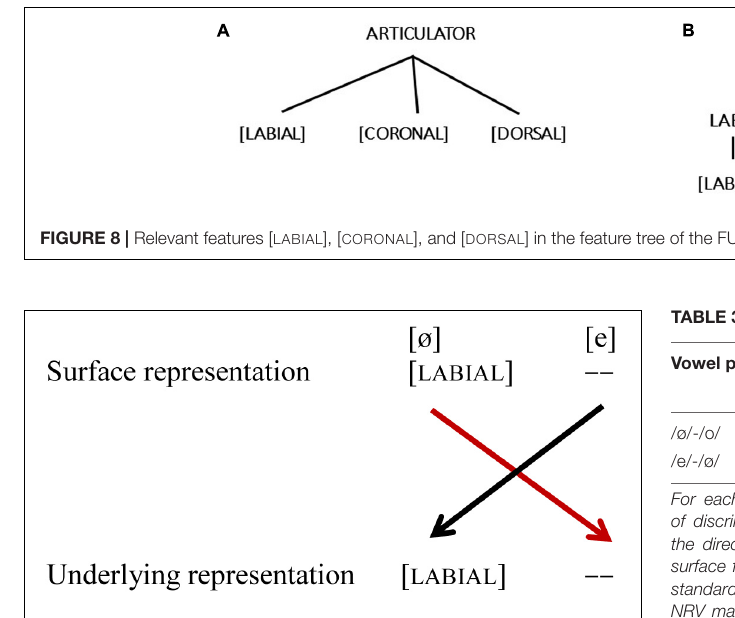
FIGURE 9 | Asymmetrical perception of the vowel pair /e-ø/. Black lines indicate no-mismatch, the red line indicates a mismatch. [– –] indicates no feature selected (SR) and node lacking (UR).